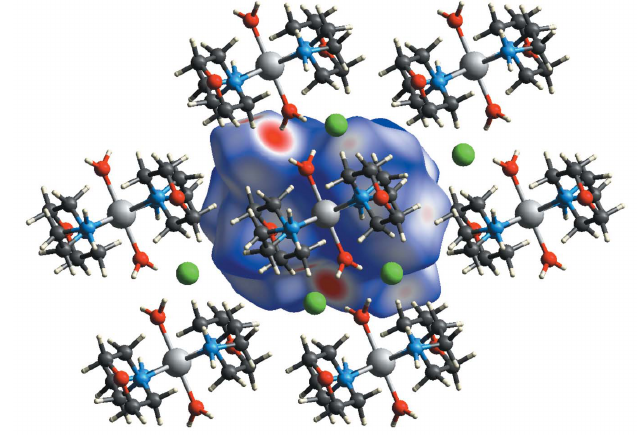
Figure 5 The Hirshfeld surface of the title compound mapped over d norm , showing the relevant close contacts.